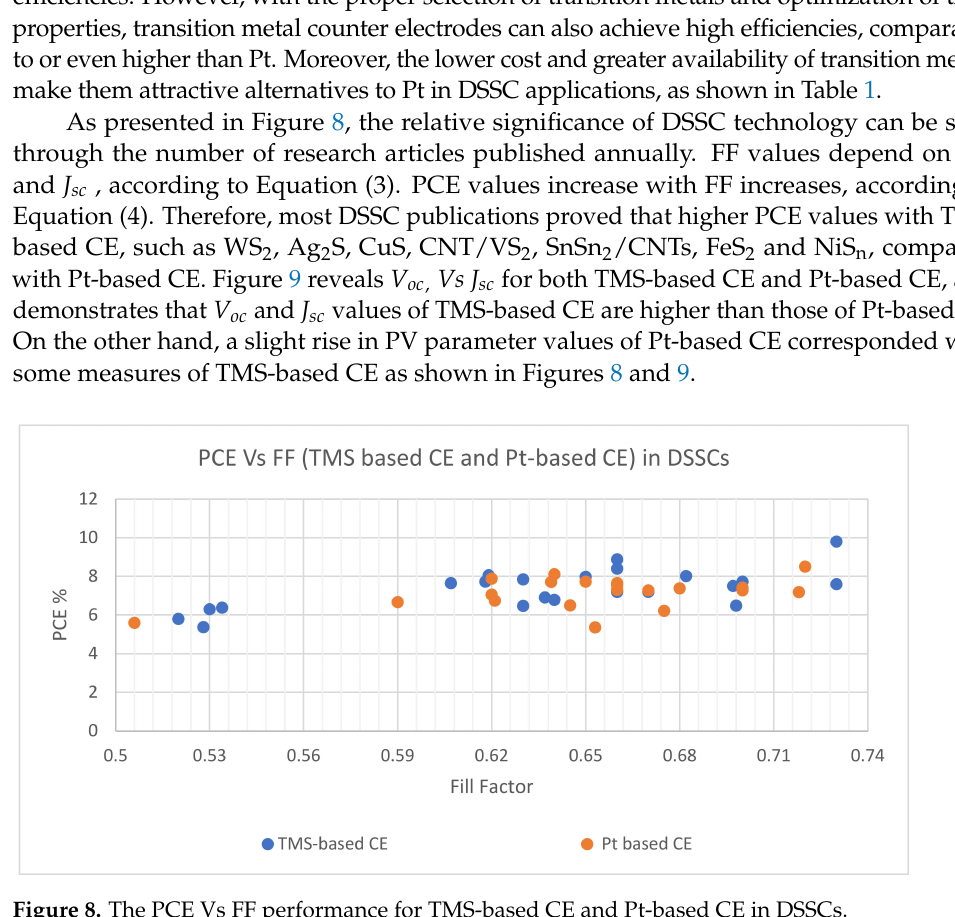
Figure 8. The PCE Vs FF performance for TMS-based CE and Pt-based CE in DSSCs.